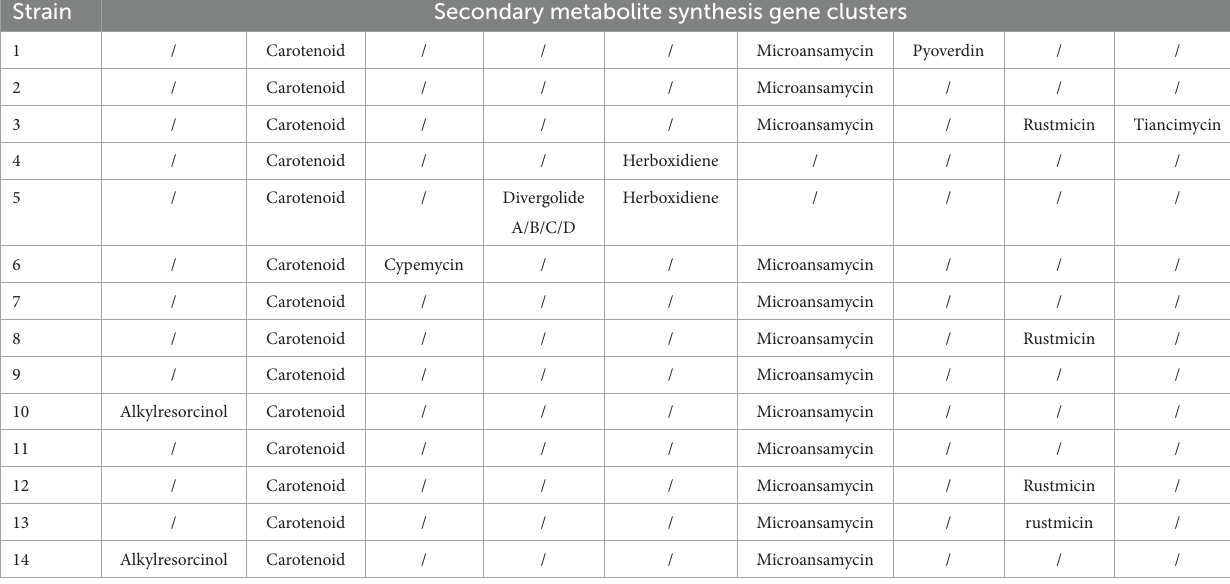
TABLE 3 Comparative results of secondary metabolite biosynthesis gene clusters predicted from the 14 strains’ genomes of the genus Herbiconiux. Strain Secondary metabolite synthesis gene